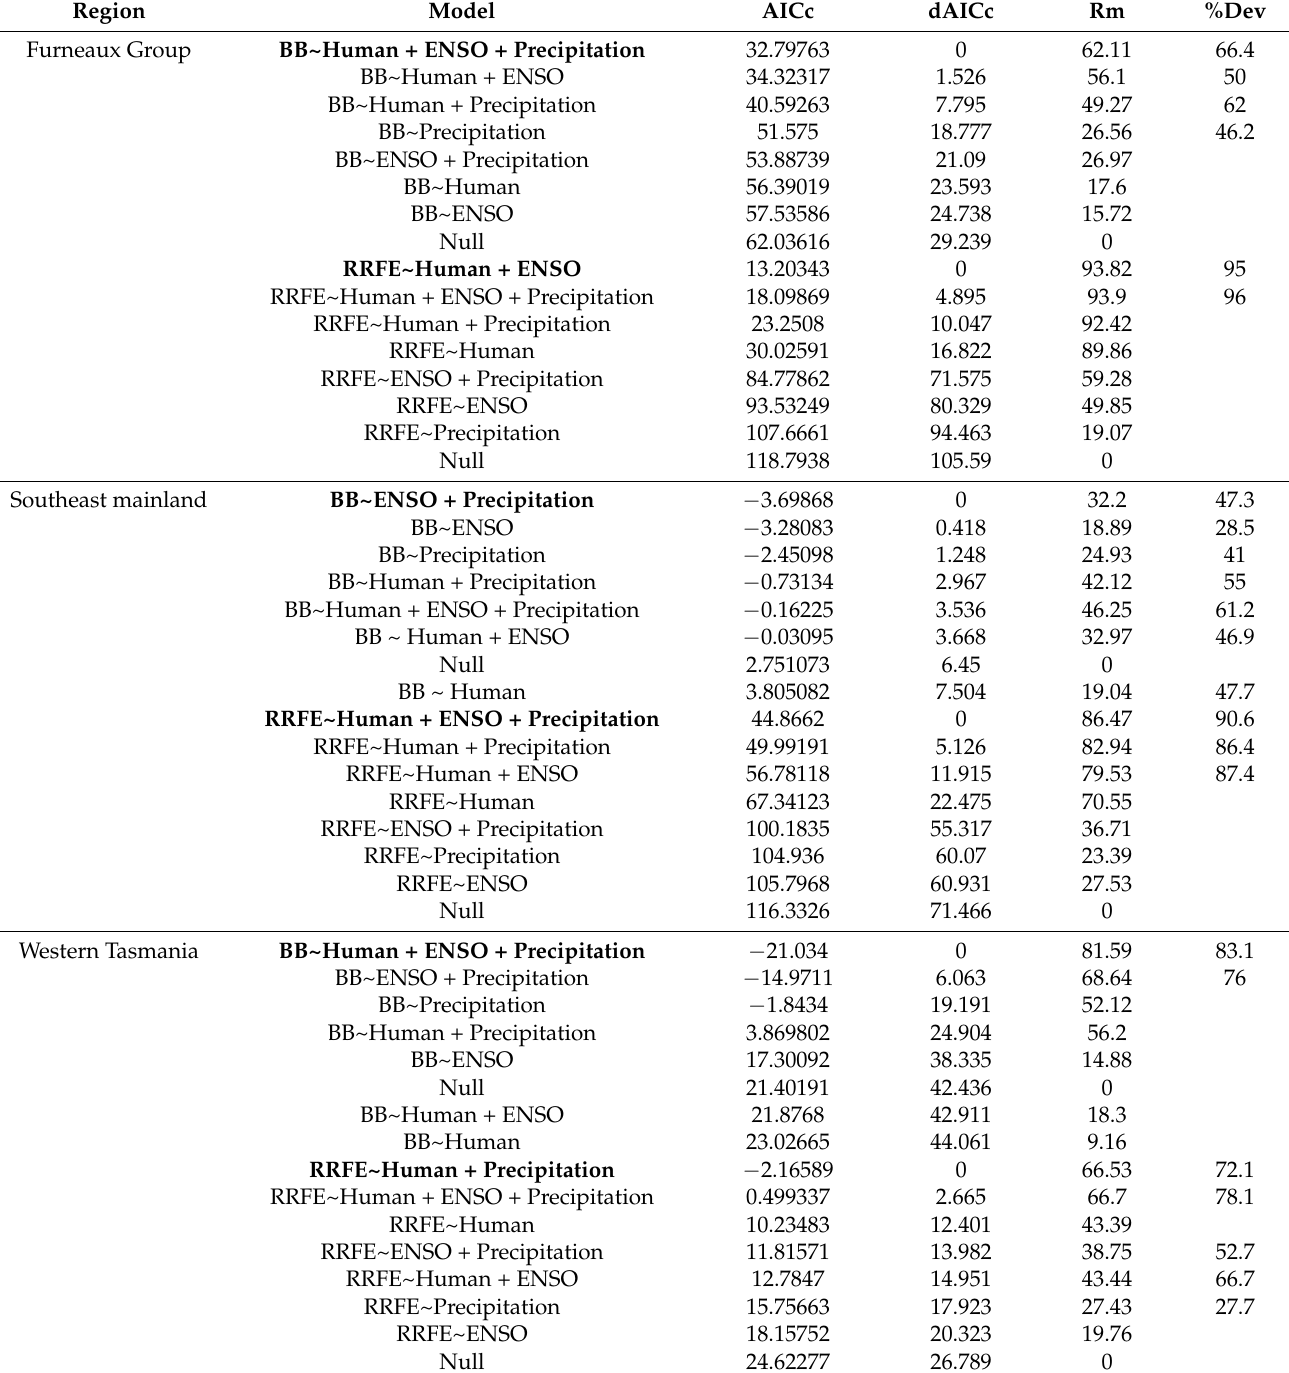
Table 2. Generalized linear modelling (GLMs) of biomass burned (BB) and recurrence-rate-of-fire-episodes (RRFE) as a function of ENSO, SWW-driven effective precipitation and anthropogenic land use (human). Models are ranked based on corrected Akaike’s information criterion corrected for small sample sizes (AICc), and top models are in bold. Percentage of deviance (%Dev) explained by models and marginal R 2 (Rm) are also